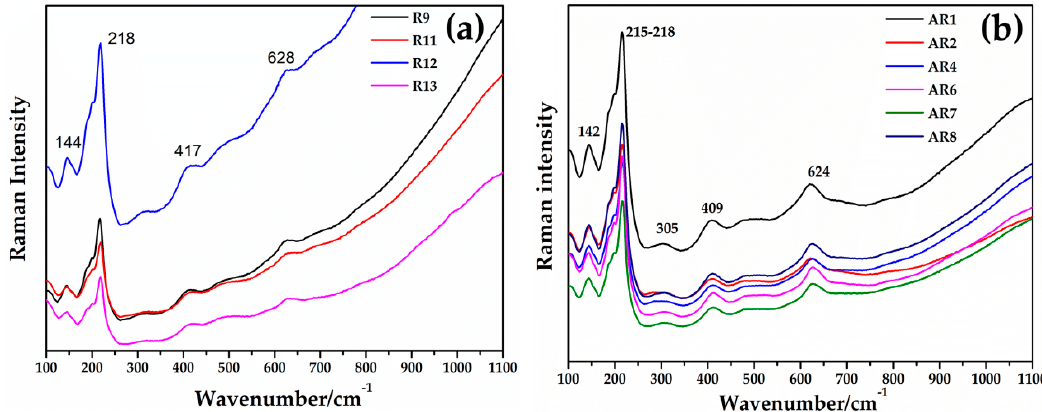
Figure 20. Raman spectrum of cuprite (Cu 2 O) detected in Gr-4 ( a ) and Gr-5 ( b )